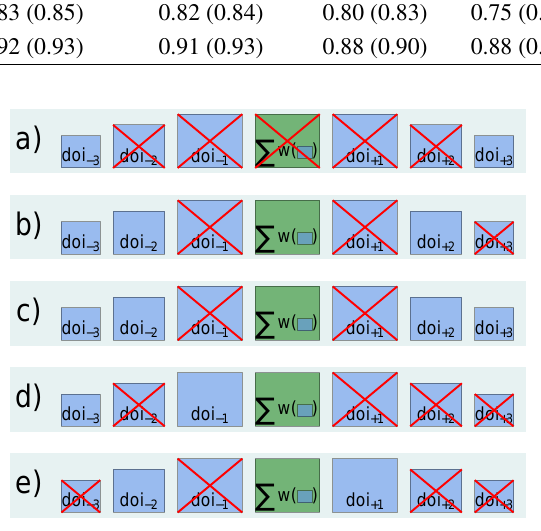
Figure 4. Summary of different combinations of necessary daily binary POLA maps for a cloud-covered pixel (green) to be classified as POLA. This is based on WFR w = 0.02, w = 0.16, w = 0.32 and th = 0.34. Colors correspond to Figure 3. Crossed out 3 2 1 boxes symbolize missing data (blue boxes) or a classification as non-POLA (green